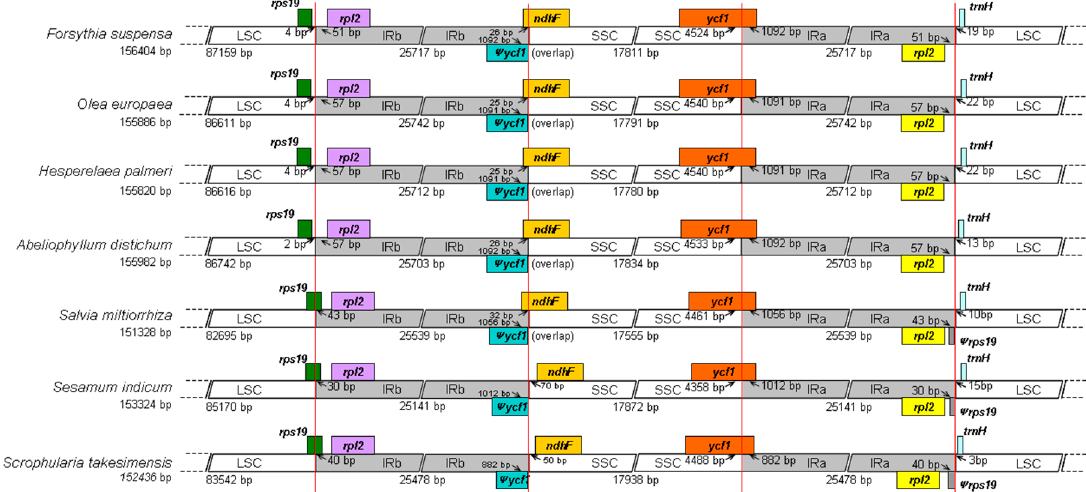
Figure 2. Comparisons of LSC, SSC, and IR region borders among six Lamiales chloroplast genomes. Ψ indicates a pseudogene. Colorcoding mean different genes on both sides of the junctions. Number above the gene features means the distance between the ends of genes and the junction sites. The arrows indicated the location of the distance. This figure is not to scale.